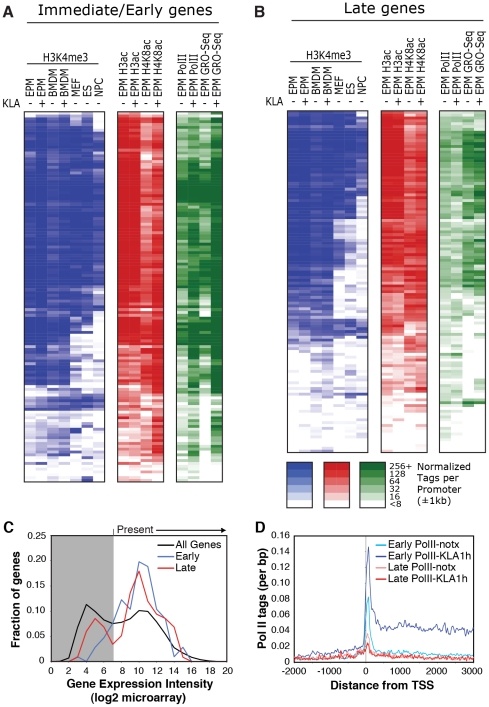
Relationships of histone modifications and RNA polymerase II at I/E and late TLR4-responsive promoters.A, B. Heat maps of normalized tag densities for the indicated histone marks, total RNA polymerase II (Pol II), or GRO-Seq. Values for murine embryonic fibroblasts (MEFs), murine embryonic fibroblasts (ES), and neuronal progenitor cells (NPCs) are based on data reported in [33]. All other lanes represent values from elicited peritoneal macrophages treated with KLA or control solvent for 1 h. C. Distribution of gene expression values as measured by DNA microarray for I/E and late TLR-responsive genes under basal conditions. Values to the right of the gray box are considered to be confidently above signal background. Similar results are found when using RNA-Seq to quantify expression levels (Figure S2C). D. Distribution of RNA polymerase II at I/E and late genes.